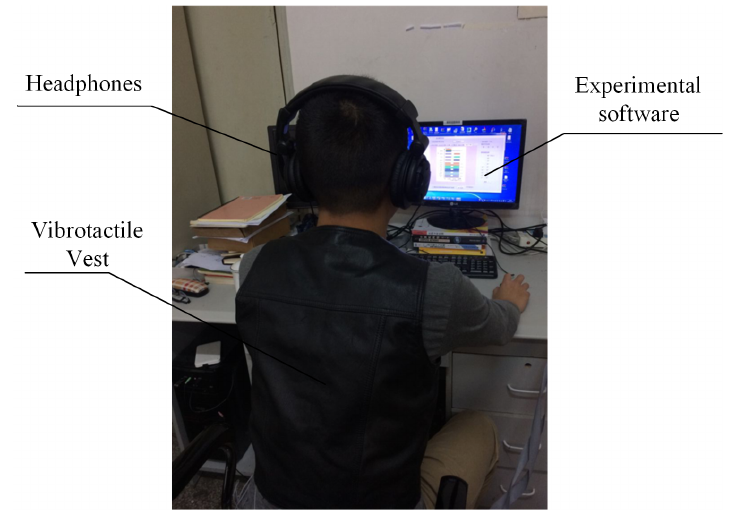
Figure 5. A subject during the